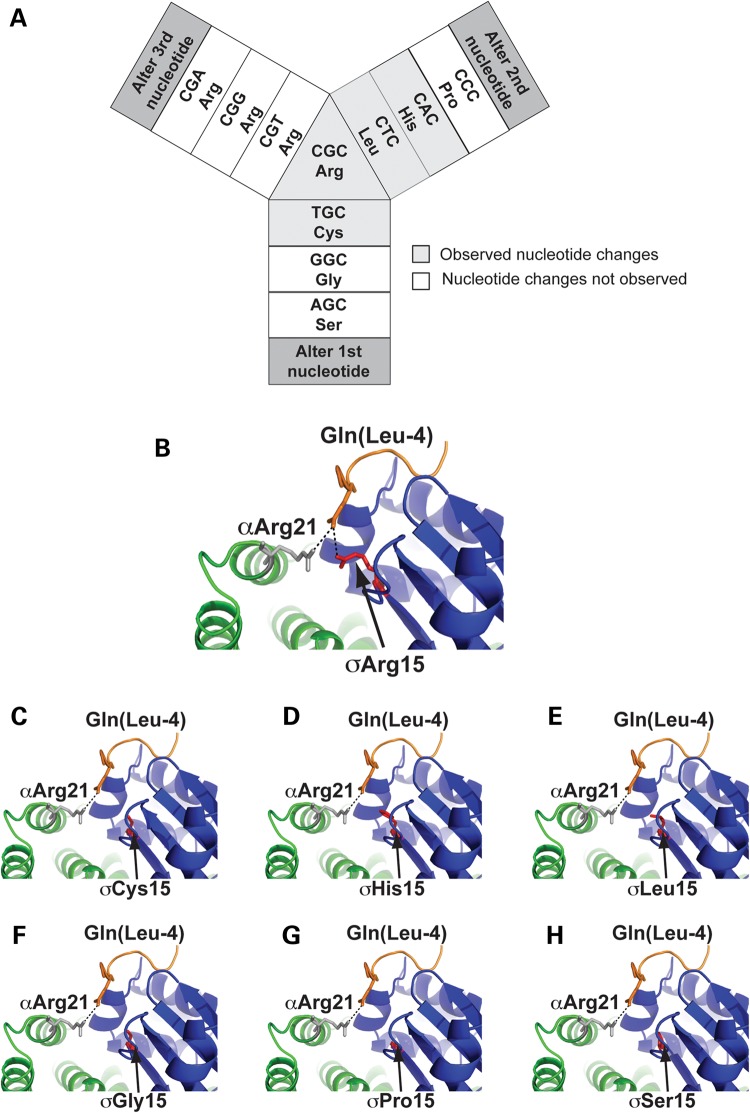
Observed and predicted mutations at the AP2S1 Arg15 (R15) residue. (A) Schematic representation of possible nucleotide and amino acid substitutions affecting codon 15. Substitutions affecting the first or second nucleotide of codon 15 (CGC) are predicted to lead to one of six possible non-synonymous mutations or variants, which are Cys15 (TGC), Gly15 (GGC), His15 (CAC), Leu15 (CTC), Pro15 (CCC) or Ser15 (AGC). Substitutions affecting the third nucleotide of the CGC triplet are predicted to lead to synonymous variants only. (B) Crystal structure of the α-subunit (green) and σ2-subunit (blue) of the AP2 heterotetrameric complex bound to an acidic (Gln-containing) dileucine cargo protein motif [PDB file 2JKR (18)]. The key polar contacts (black dashed lines) between the σ2-subunit Arg15 residue (σArg15, red) and α-subunit Arg21 residue (αArg21, grey), and a Gln residue located four residues from the first Leu residue of the acidic dileucine motif [Gln(Leu-4), orange], are shown. (C–G) Structural analysis of six potential Arg15 mutations demonstrating that the observed mutants (Cys15, His15 and Leu15) and non-observed mutants (Gly15, Pro15 and Ser15) are all predicted to result in the loss of the key polar contact with the cargo protein Gln (Leu-4) residue.